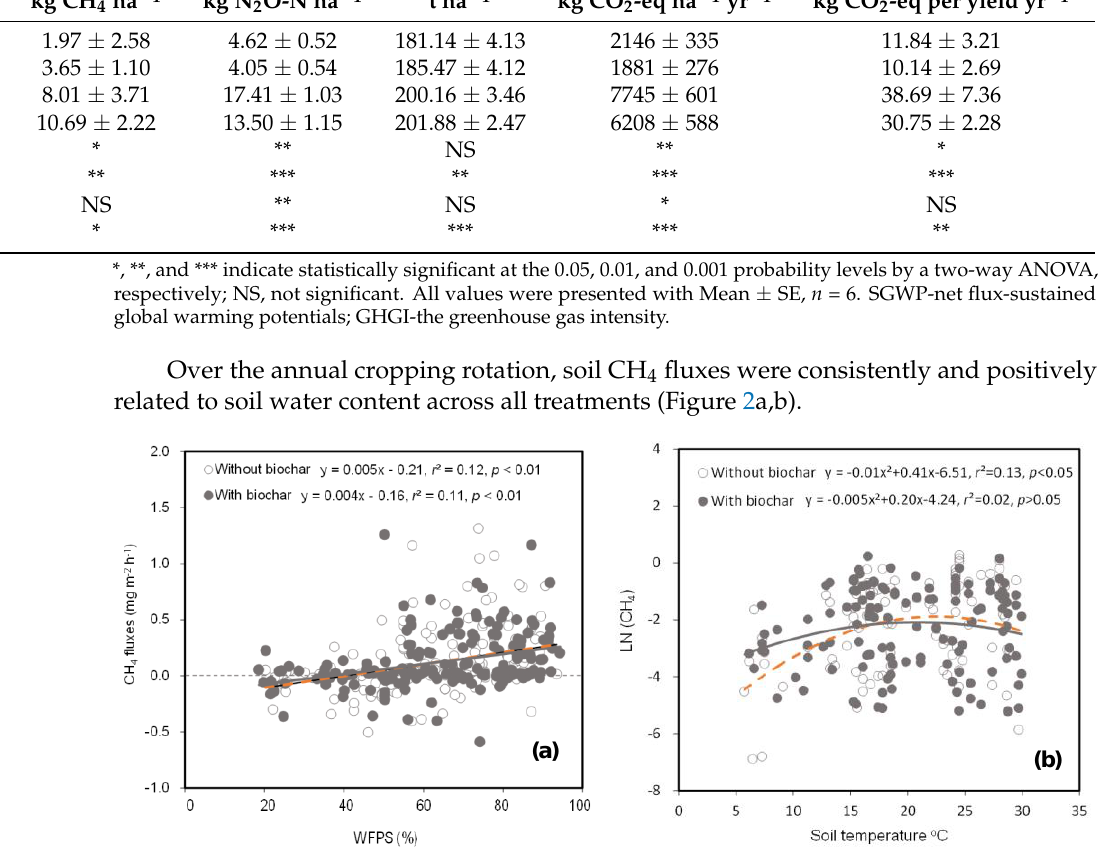
Figure 2. Dependence of CH 4 fluxes on soil WFPS over the annual greenhouse vegetable cropping system( a ); Dependence of CH 4 fluxes on soil temperature ( b ), CH 4 fluxes was log-transformed, LN means natural logarithm.